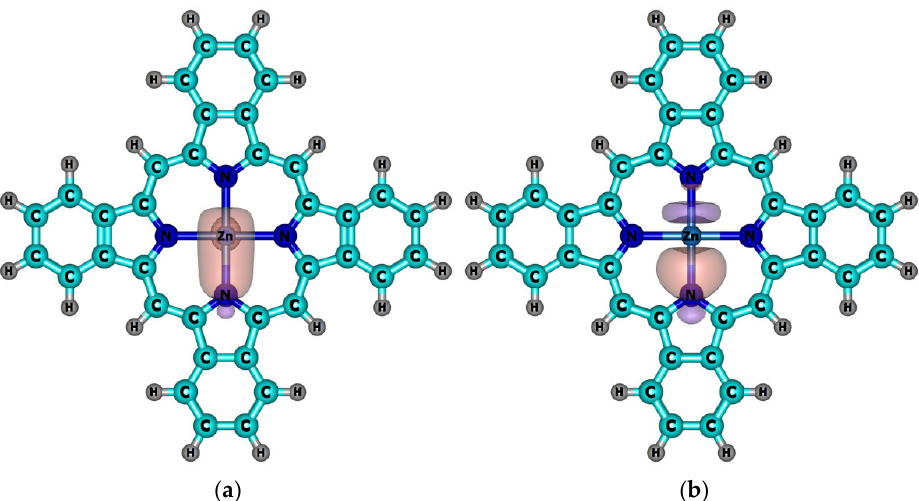
Figure 2. Schemes of the dominant donor–acceptor interactions between Zn and the TBP ligand. ( a ) The result of the orbital interaction of the type LP(N) → 4 s (Zn) (E (2) = 42.6 kcal mol −1 ); ( b ) the result of the orbital interaction of the type LP(N) → 4 p (Zn) (E (2) = 35.5 kcal mol −1 ). Only one of the four corresponding interactions is demonstrated.